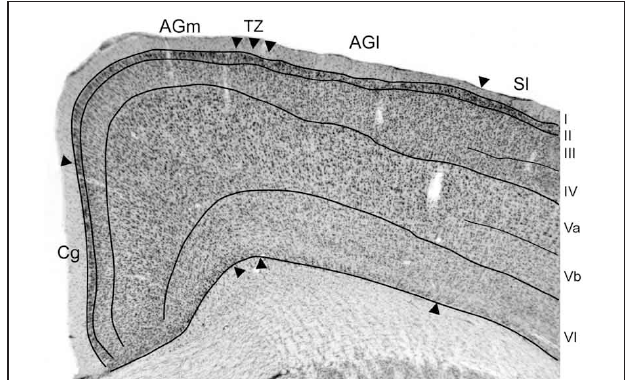
FIGURE 2 | Photomicrographdepicting the cytoarchitecture of MI cortex located 1.5mm rostral to bregma. The transitional zone (TZ) between the medial (AGm) and lateral (AGl) agranular areas is indicated by arrowheads. Additional arrowheads indicate the MI borders with the cingulate (Cg) and somatosensory (SI) cortical areas. Thin lines indicate laminar boundaries for layers I–VI.